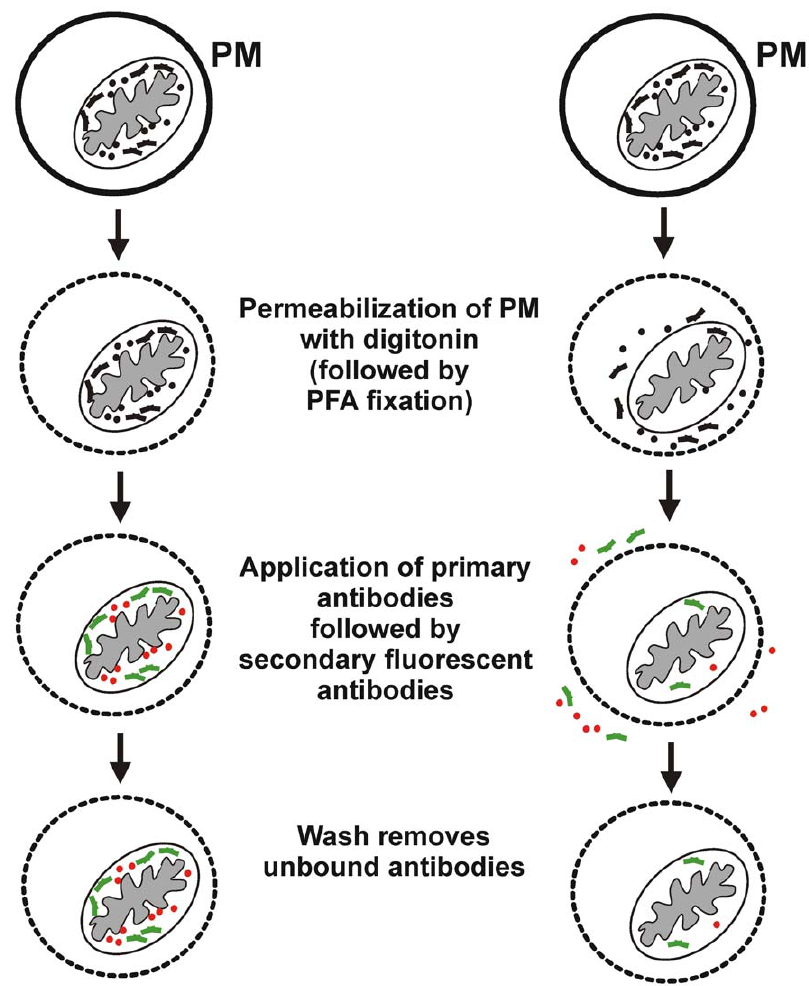
Figure 1. Schematic of digitonin permeabilization of plasma membrane to detect redistribution of cyt c and Smac by flow cytometry. Cells are permeabilized with digitonin followed by paraformaldehyde (PFA) fixation. Primary antibodies specific for target proteins cyt c or Smac, and fluorescently-tagged secondary antibodies, are applied to the cells followed by washing steps to remove unbound antibodies. (Left side) Flow cytometry detects cells that retain cyt c (red) or Smac (green) in mitochondria through the binding of fluorescently-tagged antibodies. (Right side) Cells that have redistributed either cyt c or Smac to the cytosol lose almost all of each protein through the permeabilized plasma membrane (PM) (dotted